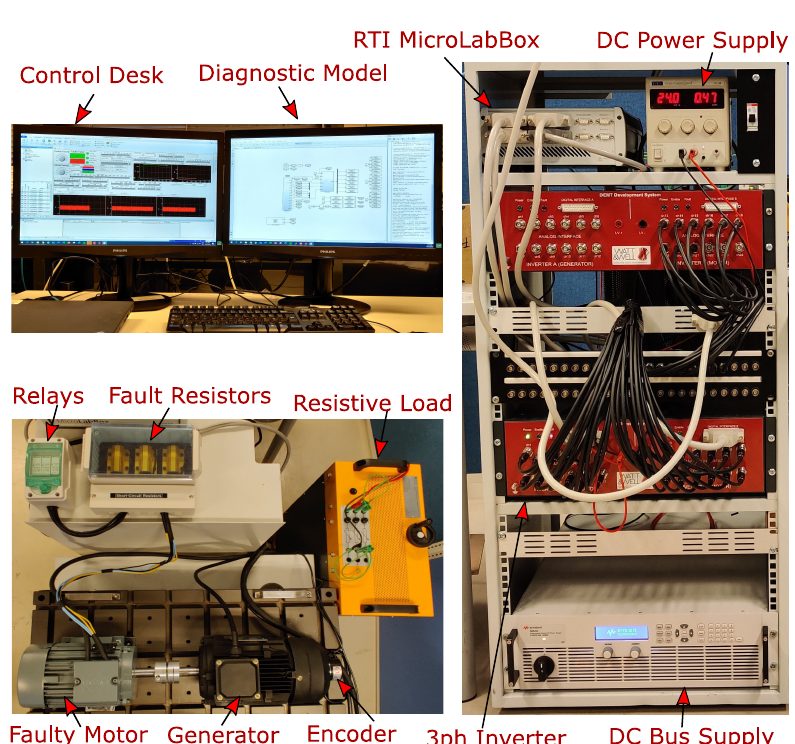
Figure 8. Applied ITSC faults on a PMSM.